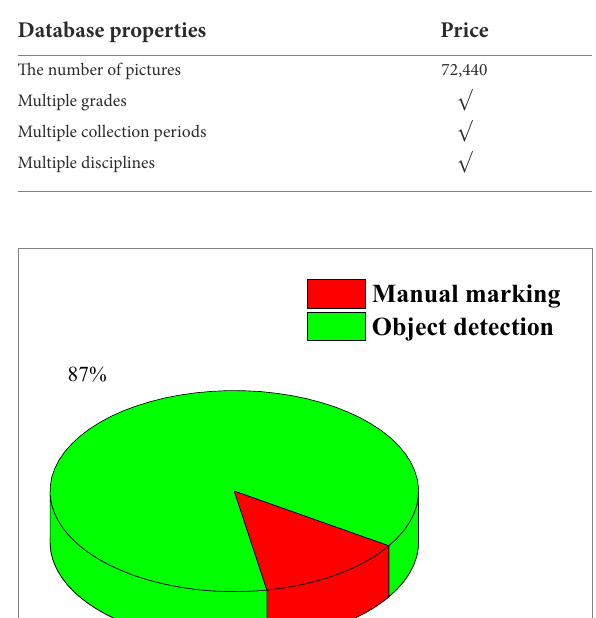
FIGURE 4 The image situation obtained by the target detection and the manual annotation.